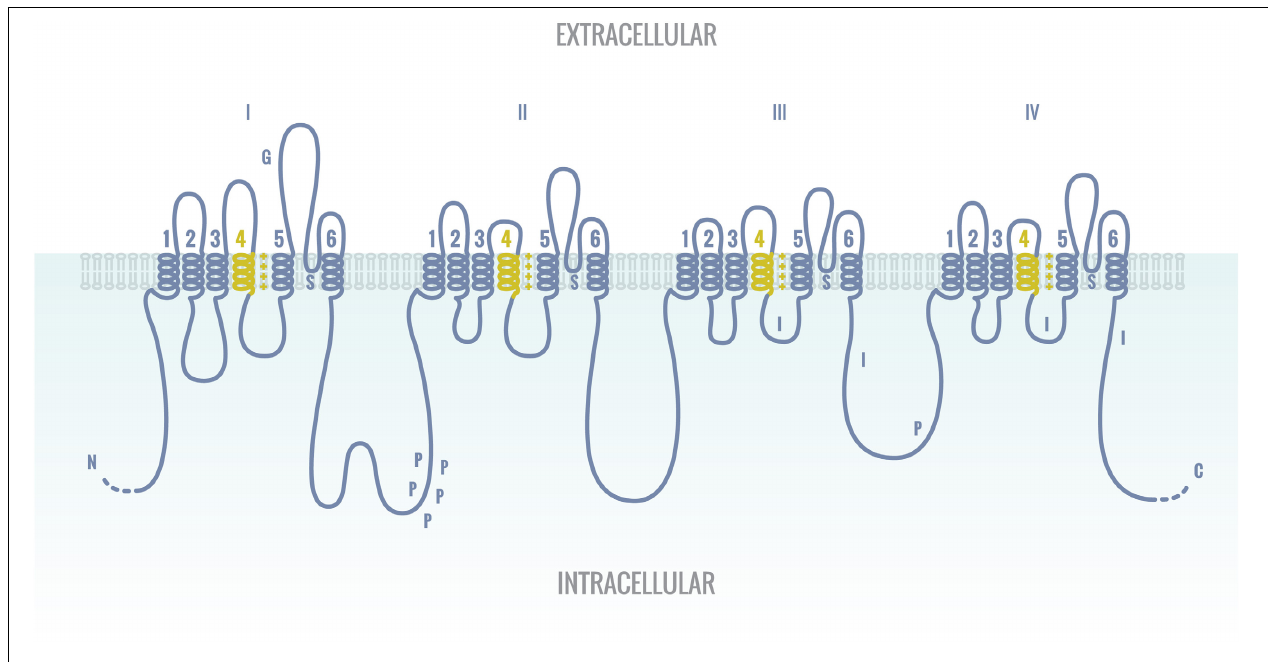
FIGURE 3 | The alpha subunit of the human sodium channel. The alpha subunit of the human sodium channel consists of four homologous domains connected by cytoplasmic linkers. Each domain is composed of six